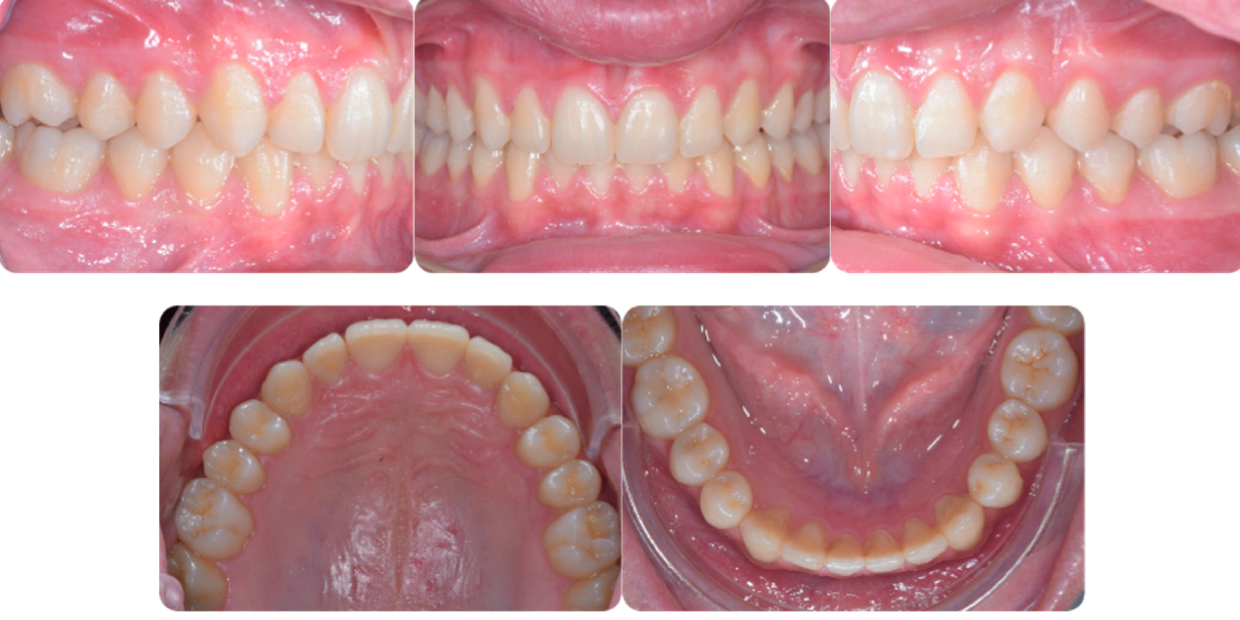
Figure 7. Post-treatment intraoral pictures after 18 months of treatment.